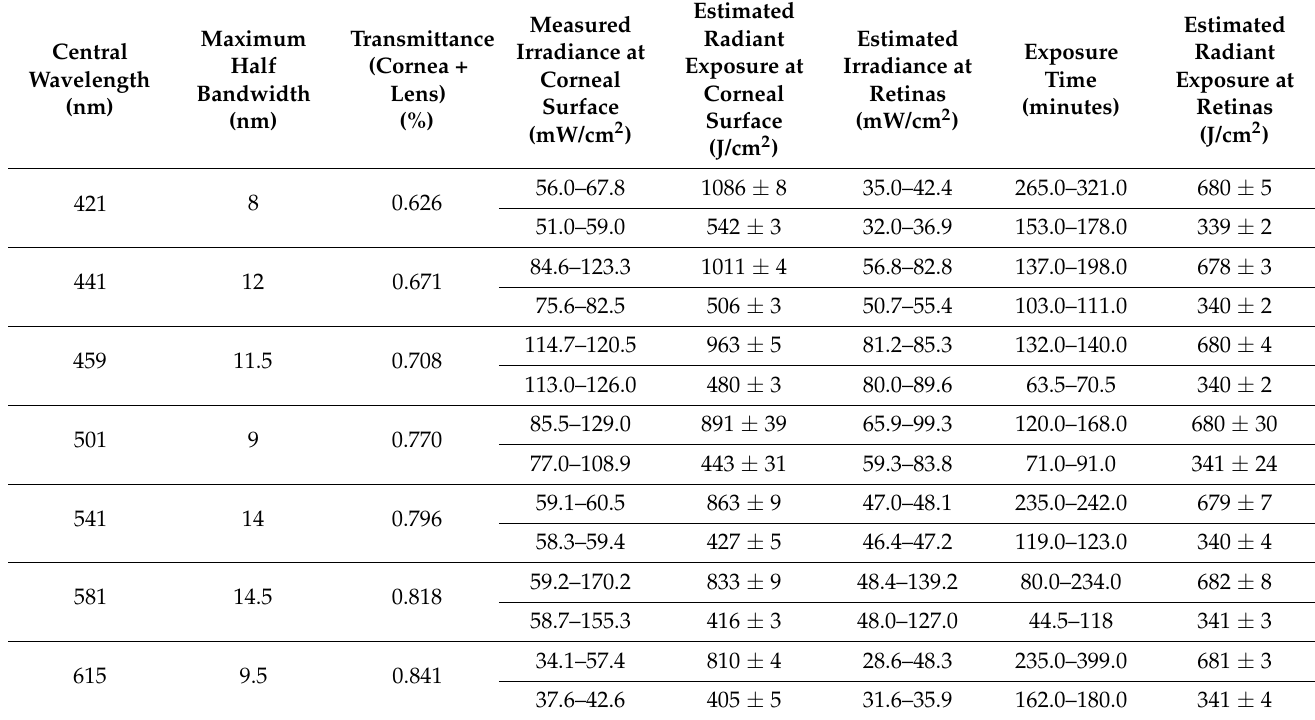
Table 1. Summary of Exposure